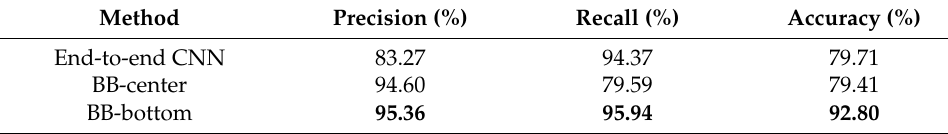
Table 6. Social distancing violation detection accuracy.